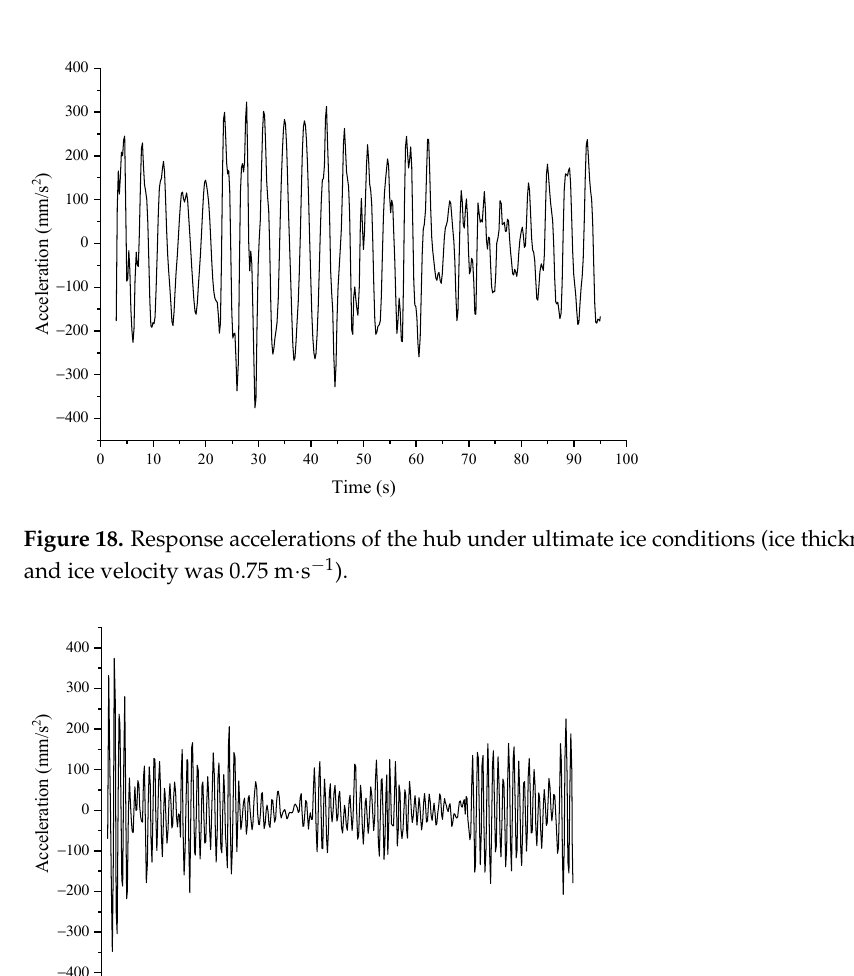
Figure 19. Response accelerations at the ToF under resonant ice conditions (ice thickness was 0.32 m and ice velocity was 0.63 m·s − 1 ).